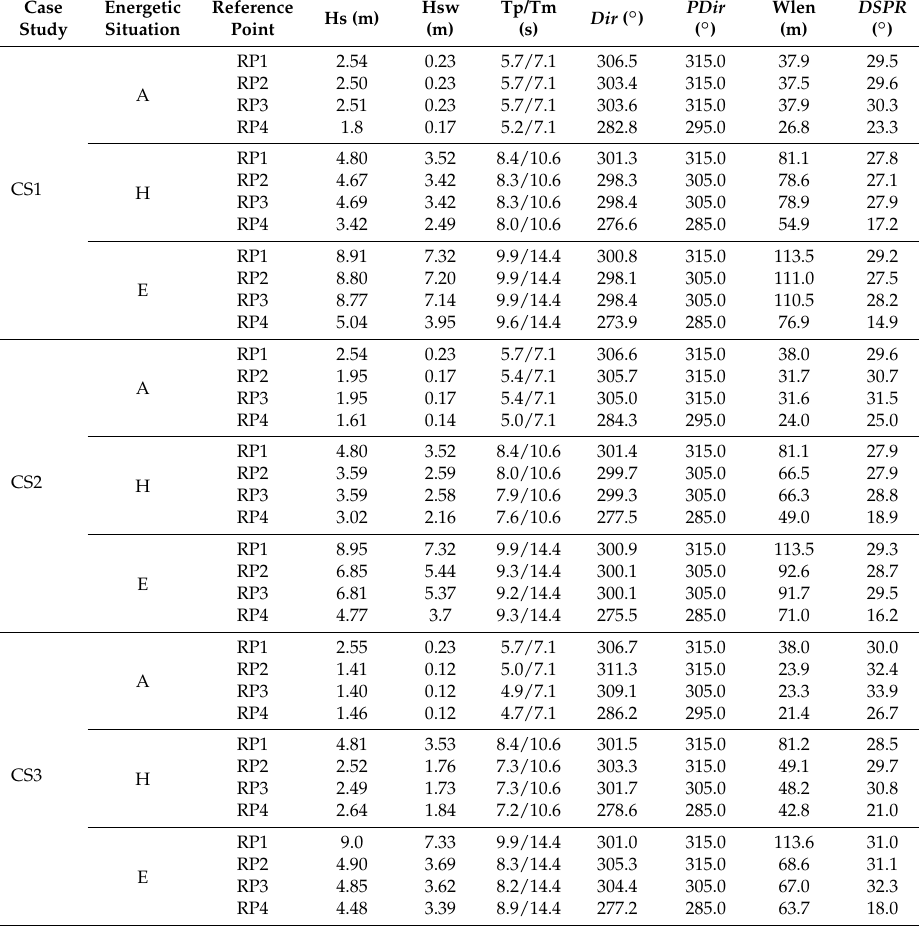
Table 4. Values of the most relevant wave parameters in the four reference points considered